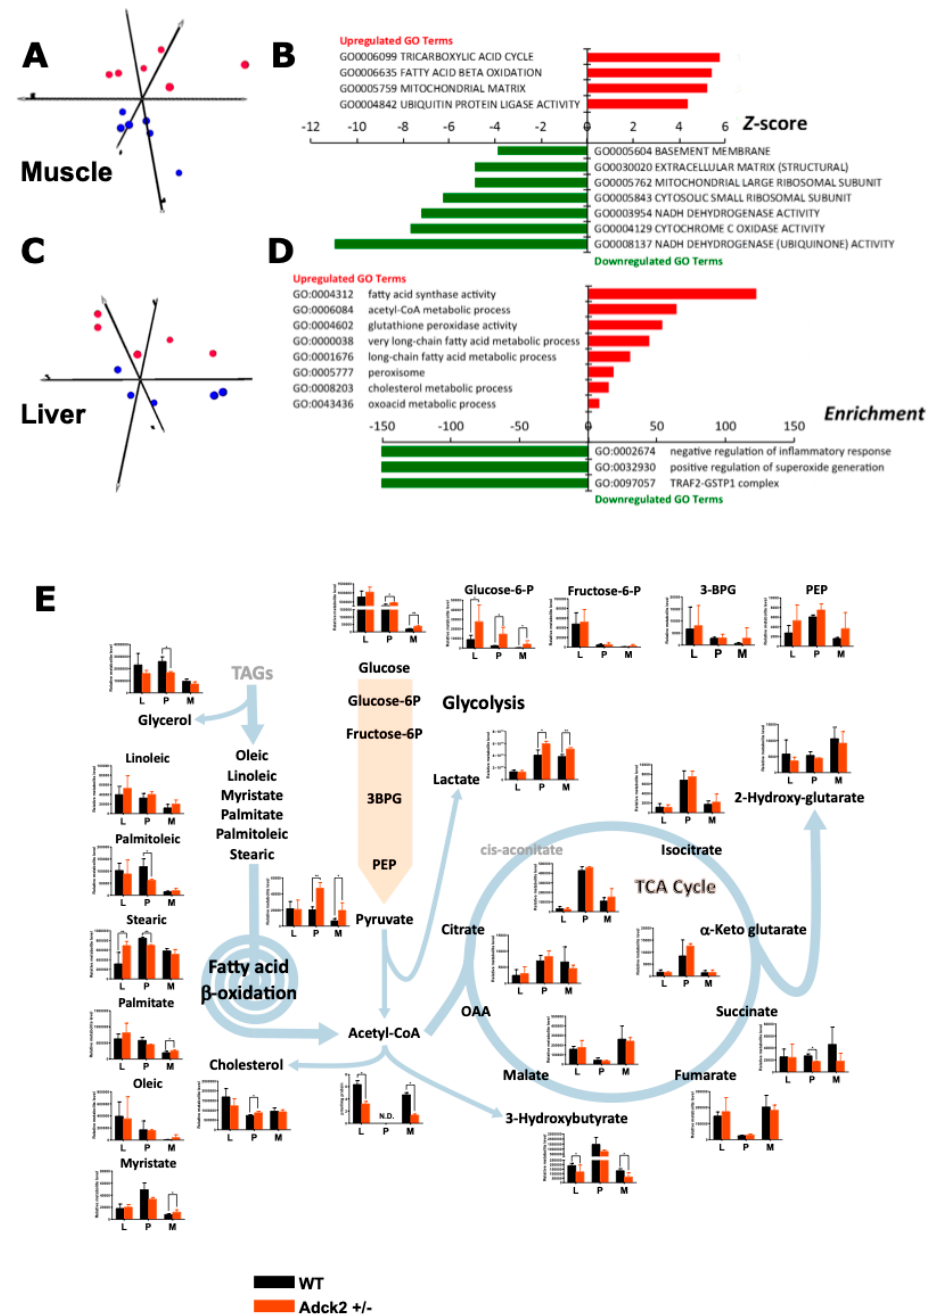
Figure 5. Transcriptome and metabolomics analyses in Adck2 +/ − mice. ( A ) Principal component analysis from microarray results in skeletal muscle of Adck2 +/ − (red symbols) and WT (blue symbols) mice ( n = 6 per group). ( B ) Bars depict gene ontology (GO) pathways significantly regulated in skeletal muscle of Adck2 +/ − vs. WT animals. ( C ) Principal component analysis from microarray results in liver of Adck2 +/ − (red) and WT (blue) mice ( n = 6 per group). ( D ) Bars depict GO pathways significantly regulated in liver of Adck2 +/ − vs. WT animals. ( E ) Metabolite profiles in skeletal muscle (M), liver (L), and plasma (P) of Adck2 +/ − and WT mice at 12 months of age are depicted. Results indicated major a ff ected components of glycolysis and FA β -oxidation pathways, as well as the Krebs cycle ( n = 6 per group). Acetyl-CoA was determined independently by HPLC in liver and skeletal muscle. N.D. Non determined. All data are n = 5–6 biological replicates per experimental group. * p < 0.05, ** p < 0.01 vs. WT. Data were analyzed using Student’s t